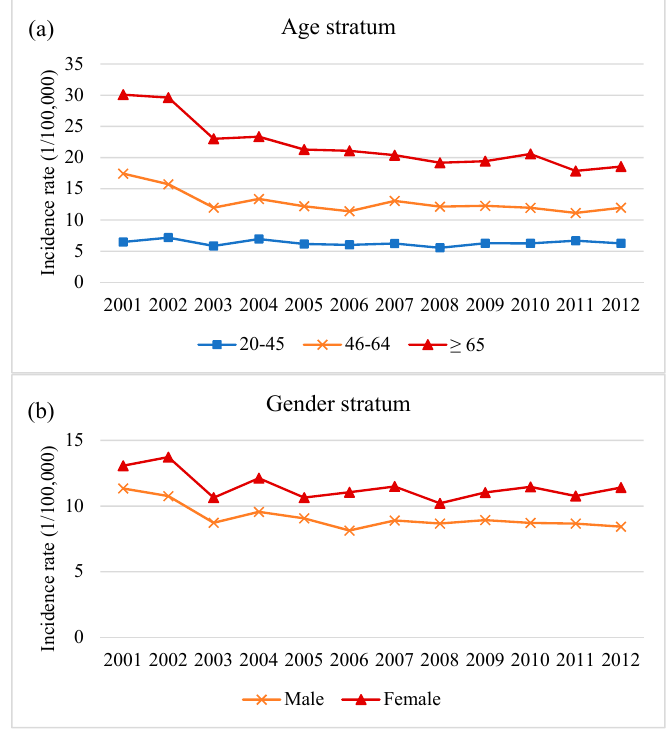
Figure 2. Annual incidence of PSVT ‐ related admissions (1/100,000). ( a ) Annual incidence of PSVT ‐ related admissions of age stratum, ( b ) Annual incidence of PSVT ‐ related admissions of gender stratum.